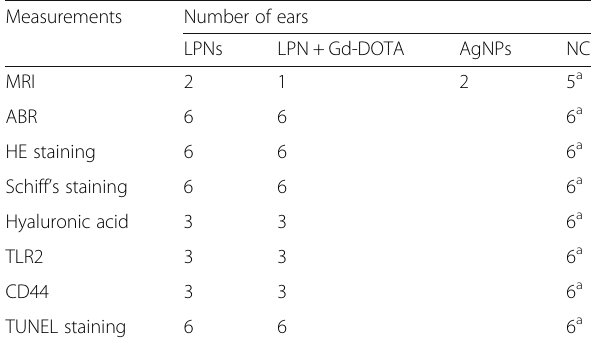
Table 2 Assignments of rats in MRI and ABR measurements post-intratympanic administration of liposome nanocarriers